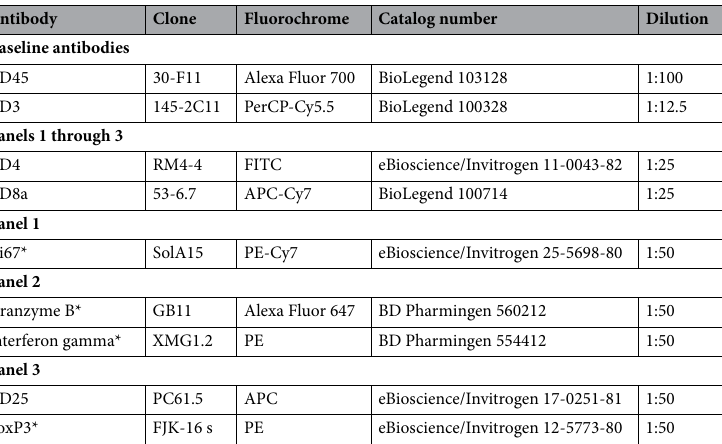
Table 1. Antibodies for leukocyte characterization via FACS. *Intracellular